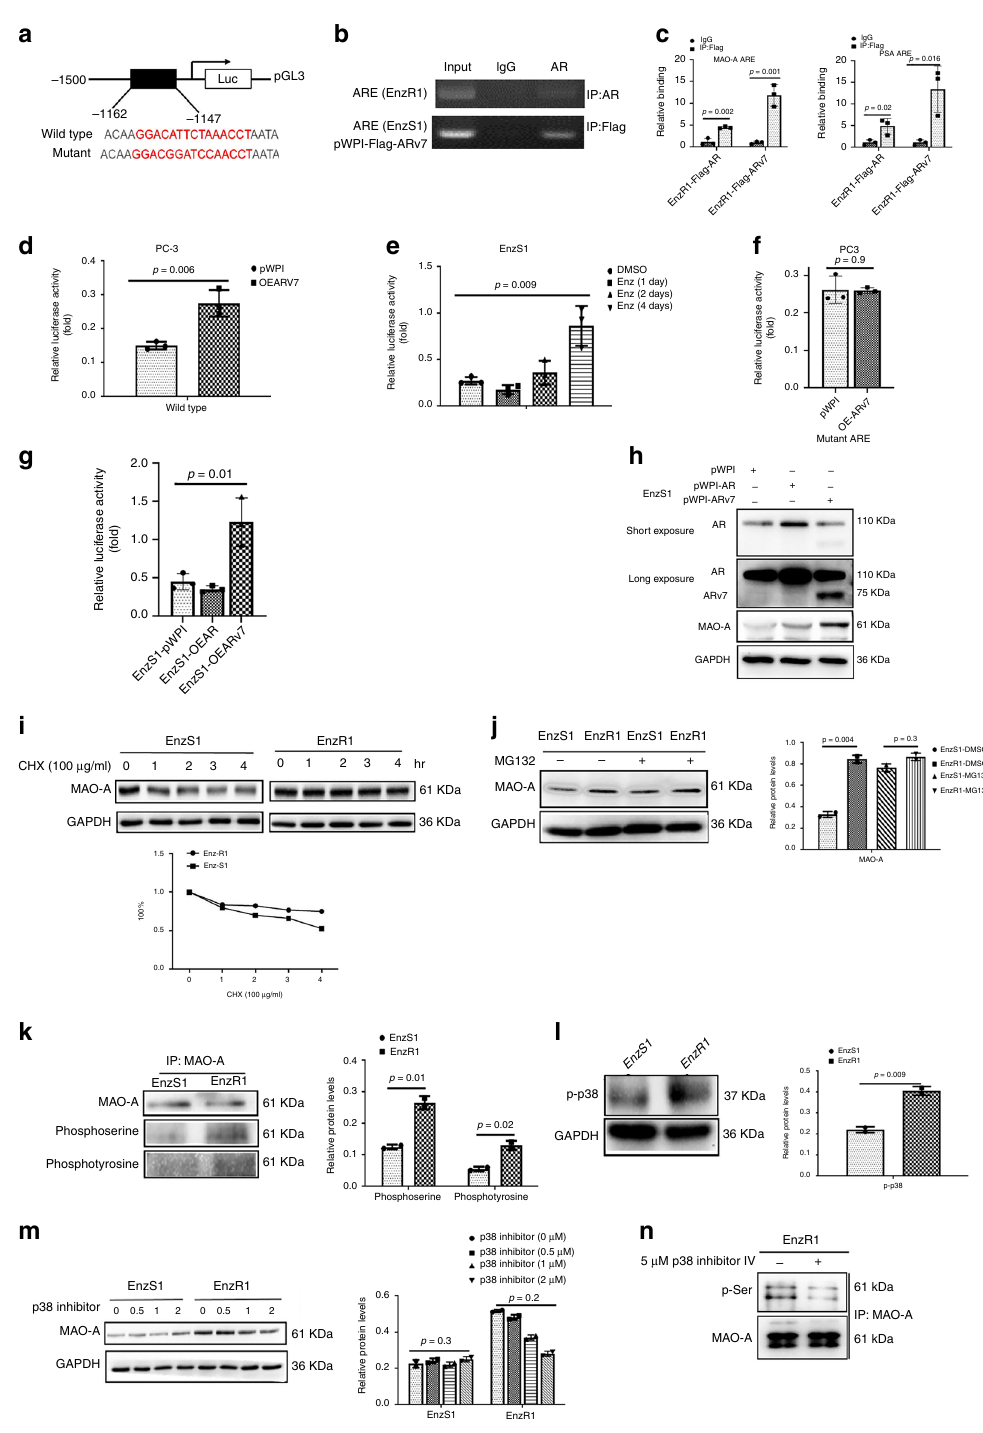
IP:FlagARE (EnzS1)